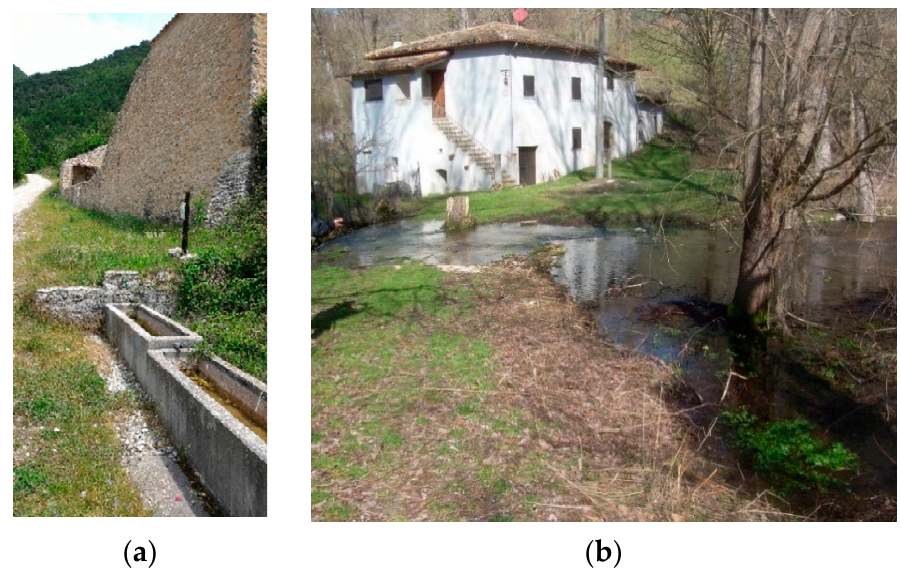
Figure 4. ( a ) An example of a dried spring located eastward of Campi village; ( b ) evidence of river discharge increase after the earthquake of 30 October 2016.